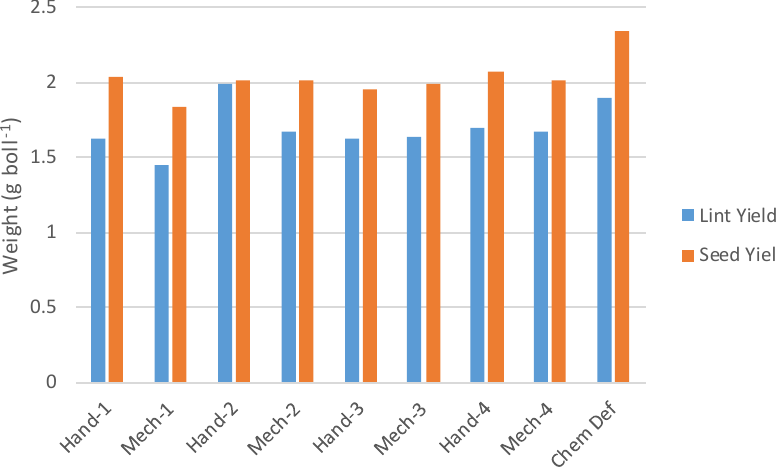
Figure 15. Yield estimation, by lint weight per boll, for field cotton grown under commercial practices common to deficit irrigated cotton in West Texas, United States. Note: the numeral following each treatment refers to which week they were treated by girdling along with girdling method (hand knife, mechanical flap brush, chemical defoliation (control), flame girdling).